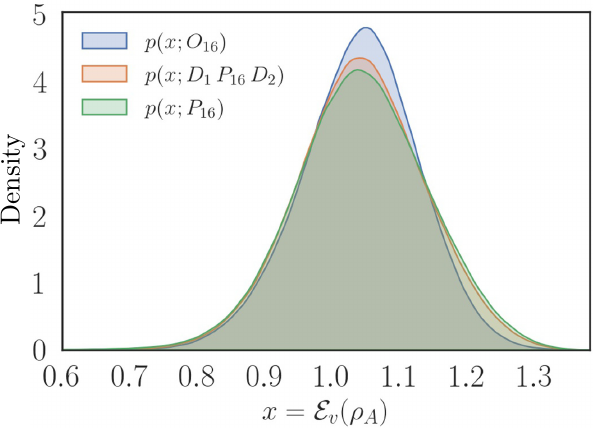
FIG. 8. The two-ququad case d 2 = 16. The distributions p ( x ; U ) of entanglement corresponding to the 2-unitary permu- tation matrix U = P 16 [Eq. (79)] and the 2-unitary orthogonal matrix U = O 16 [Eq. (80)]. The distributions are clearly distin- guishable and show that P 16 and O 16 are not LU equivalent. Also shown is the entanglement distribution corresponding to enphased P 16 — D 1 P 16 D 2 , where D 1 and D 2 are diagonal uni- taries—which is not LU equivalent to either P 16 or O 16